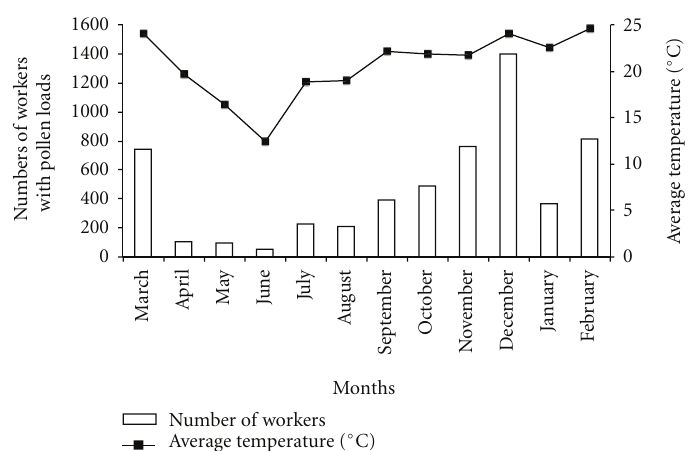
Figure 3: Mean number of pollen foraging workers of Scaptotrigona a ff . depilis related to the average temperature.